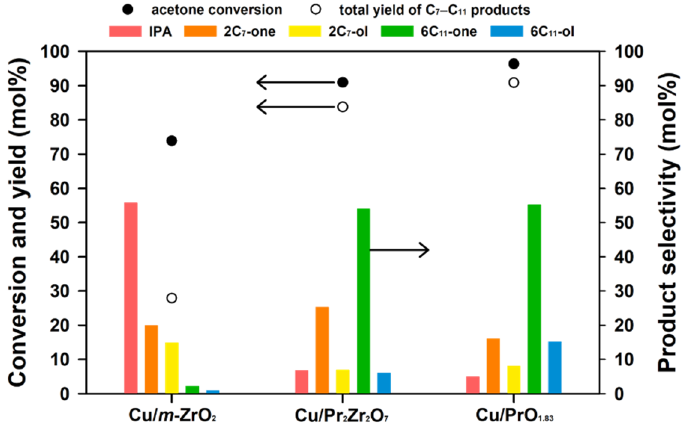
Figure 4. Catalytic performance of Cu/m-ZrO 2 , Cu/Pr 2 Zr 2 O 7 , and Cu/PrO 1.83 in the cross-coupling of acetone with butanol. Reaction conditions: 20 g reactant with the butanol/acetone mole ratio of 2, catalyst 1 g, 240 °C, and 20 h.